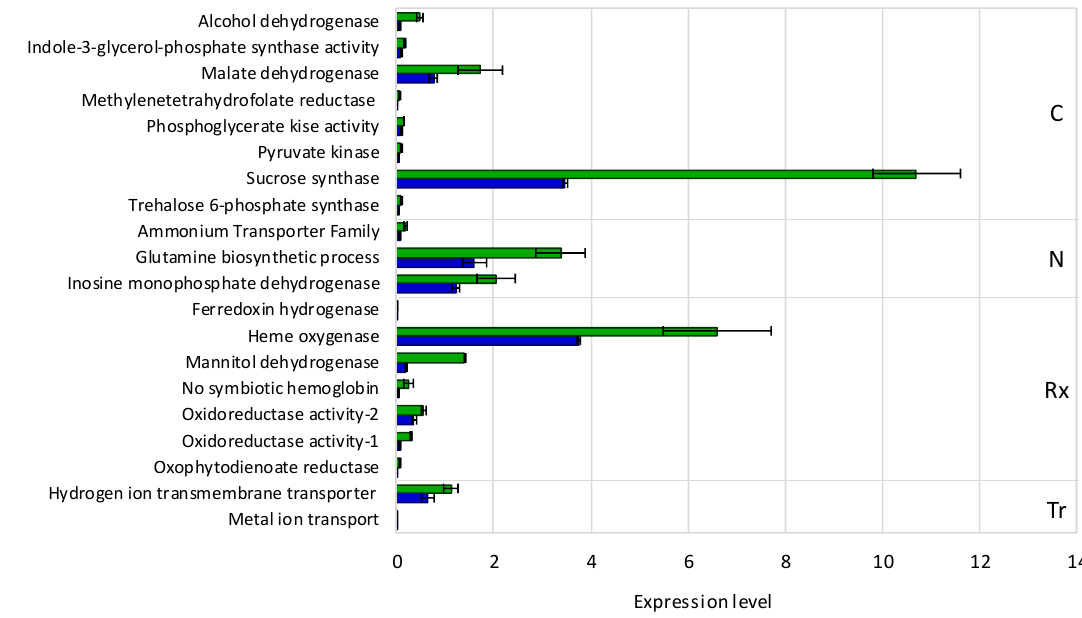
Figure 2. Relative expression level of nodule-function related genes in nodules of lpa1 (green) and BAT 93 (blue) R. etli inoculated plants, grown under control conditions. The genes functional categories are: carbon metabolism (C), nitrogen metabolism (N), redox status (Rx) and transport (Tr). Bars represent ± SD. Relative expression for each sample was calculated using the comparative threshold cycle (C t ) and the SUMO-conjugating enzyme UBC9 gene was used for normalization.